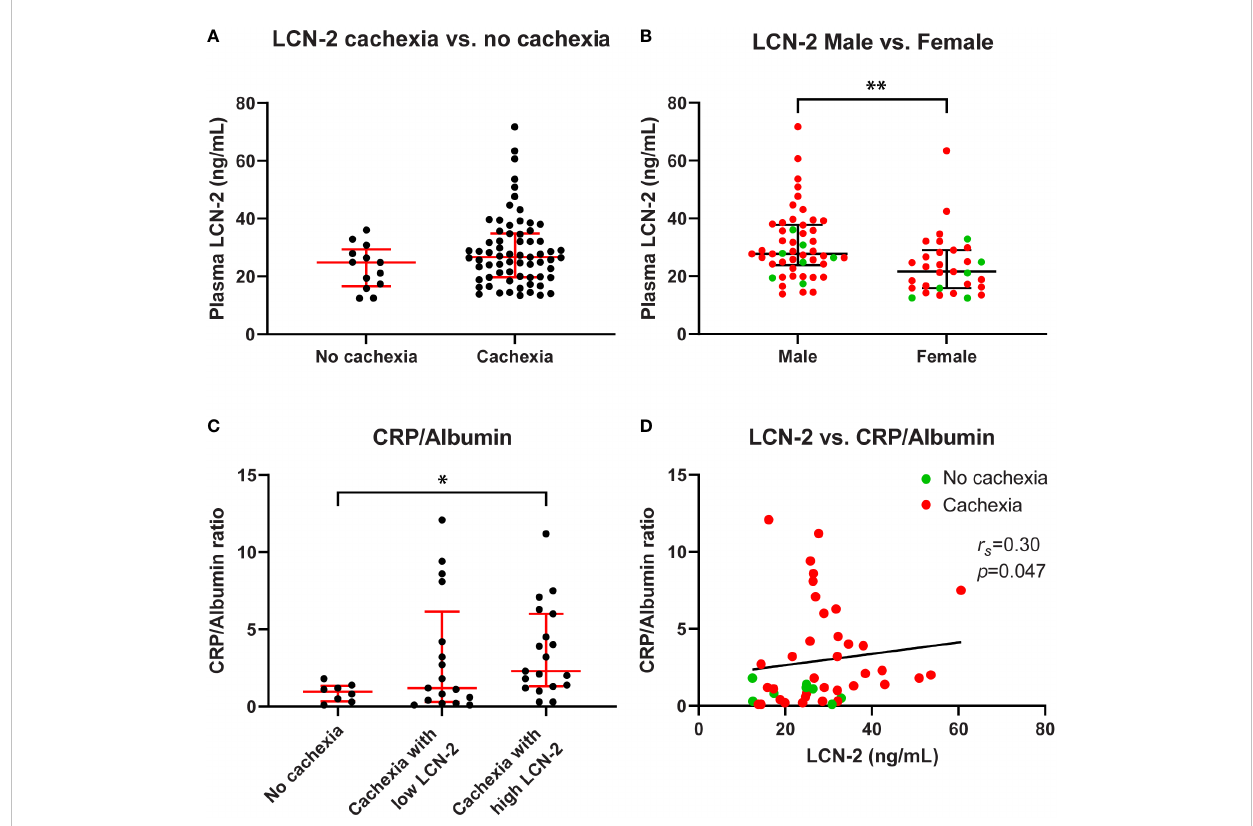
FIGURE 2 Circulating LCN-2 levels of PDAC patients differ according to sex and correlate with systemic in fl ammation. Comparison of circulating LCN-2 levels in PDAC patients with and without cachexia (A) . Comparison of circulating LCN-2 levels between male and female PDAC patients (B) . CRP/Albumin ratio in PDAC patients within the indicated study groups (n=44) (C) . Relationship between circulating LCN-2 levels and CRP/Albumin ratio in PDAC patients (n=44) (D) . Scatter plots (A – C) show the median + IQR and individual data points in each group. Mann-Whitney U test for analysis of two groups; Kruskal-Wallis test followed by Dunn ’ s post-testing for analysis of multiple groups. Spearman ’ s rank correlation coef fi cient ( r s ) was used to test for the relationship between variables. Signi fi cant differences among the groups are signi fi ed by asterisks (* p < 0.05, ** p <